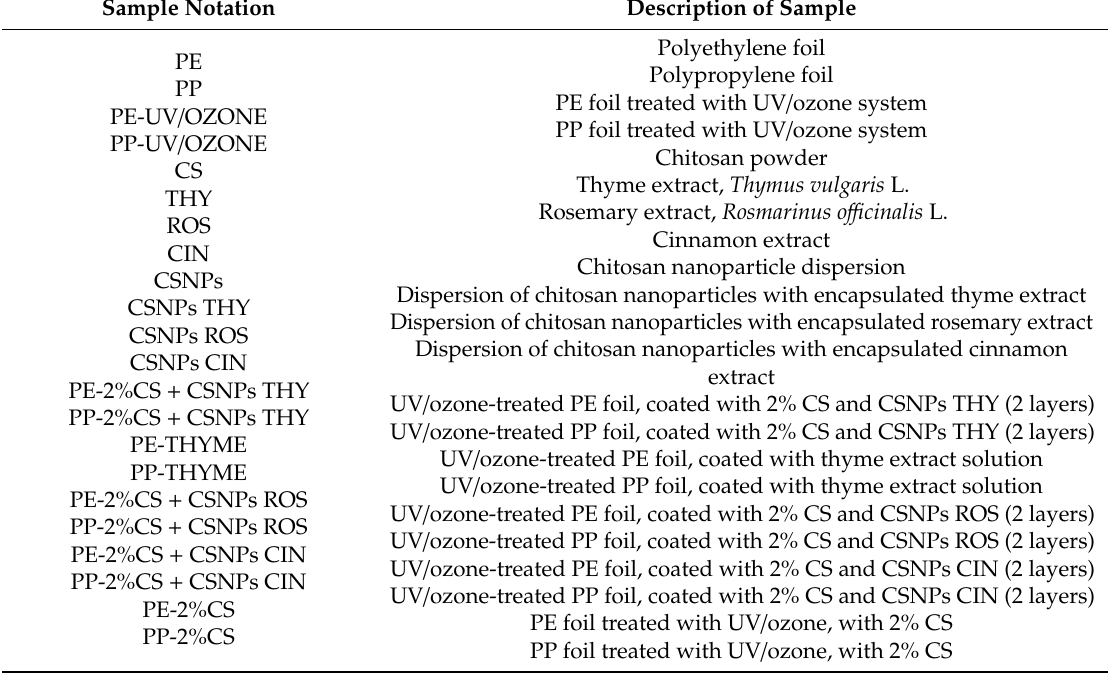
Table 11. Sample